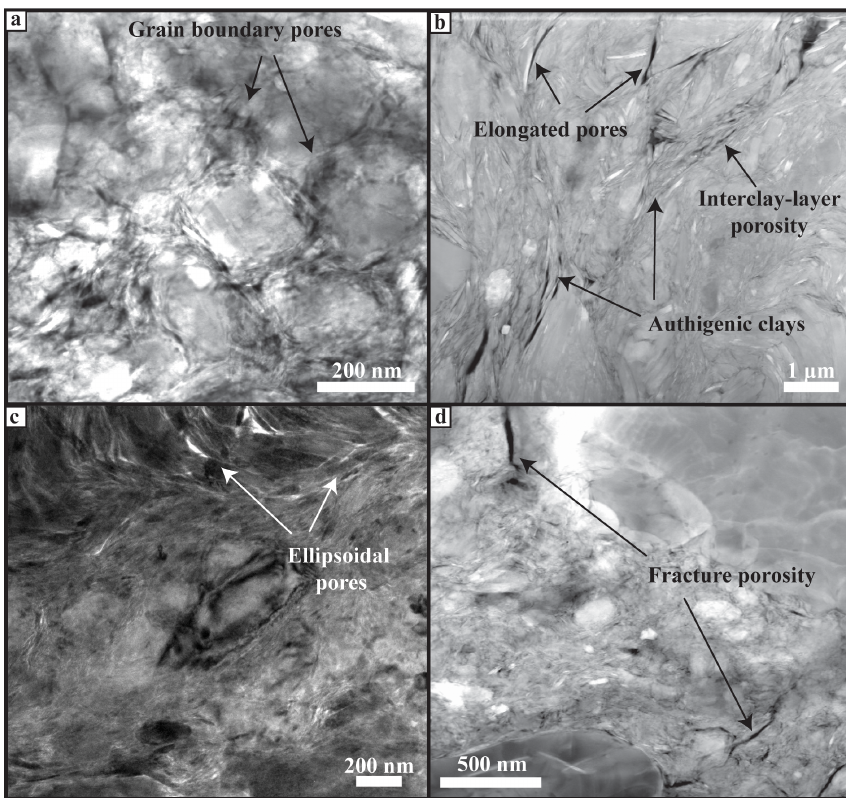
Figure 9. Transmission electron microscopy images collected from the gouge sample DFDP-1B 69_2.54 (PSZ-2). Panels (a) and (c) are bright-field (BF) images, where porosity appears as bright contrast areas. Panels (b) and (d) are high-angle annular dark-field (HAADF) images, where pores appear as dark contrasts areas. (a) TEM bright-field image of homogeneous fault gouge area. Quartz–feldspar grains, wrapped by fine authigenic clays, displaying fringe morphologies. Pores with subangular shape distributed along grain boundaries. (b) HAADF image of phyllosilicate-rich gouge area. Coexistence of fine authigenic clays with coarser clay mineral grains. Elongated pores and interlayer porosity. (c) TEM bright-field image of ellipsoidal pores in phyllosilicate-rich areas. Examples of strain shadows along quartz– feldspar grains. (d) HAADF image of fracture porosity along grain boundaries of quartz–feldspar